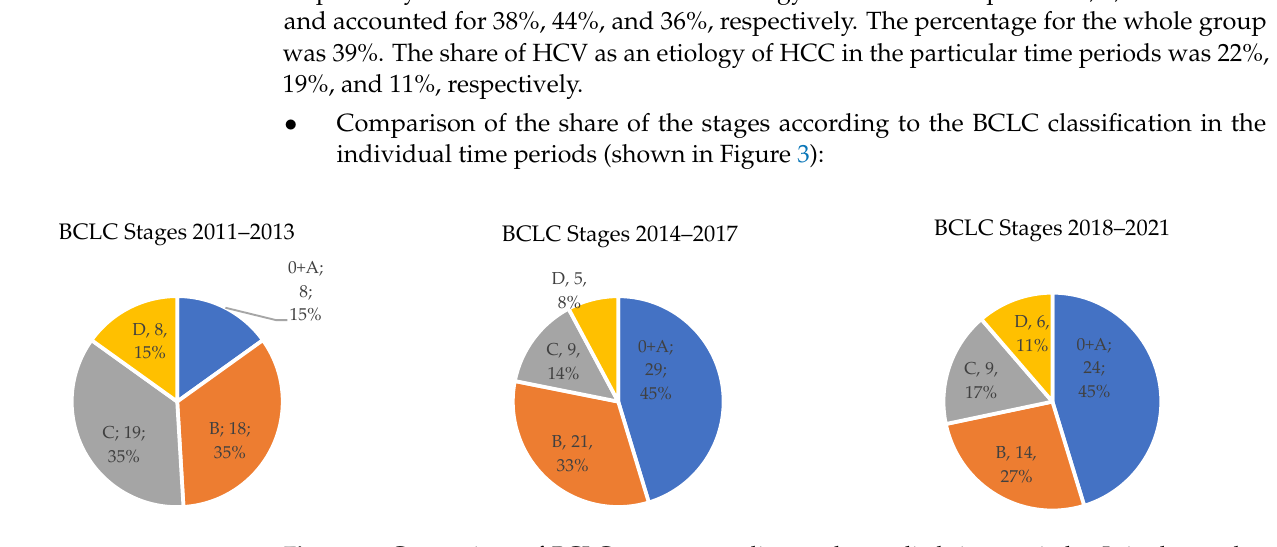
Figure 2. Overview of etiologies in % according to the studied time periods. A continuously increas- ing proportion of ALD-related HCC in the cohort and a nearly linear decrease in HCV as the etio- logical factor of HCC are shown.